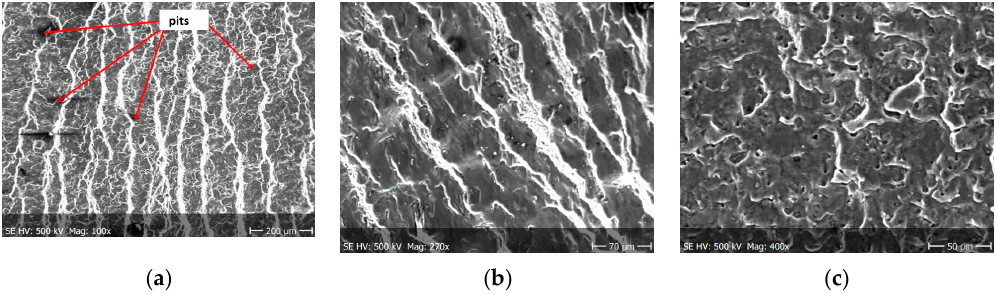
Figure 14. ( a – c ) Fracture images after 28 days in demineralised water (images taken at fracture surface of sample shown in Figure